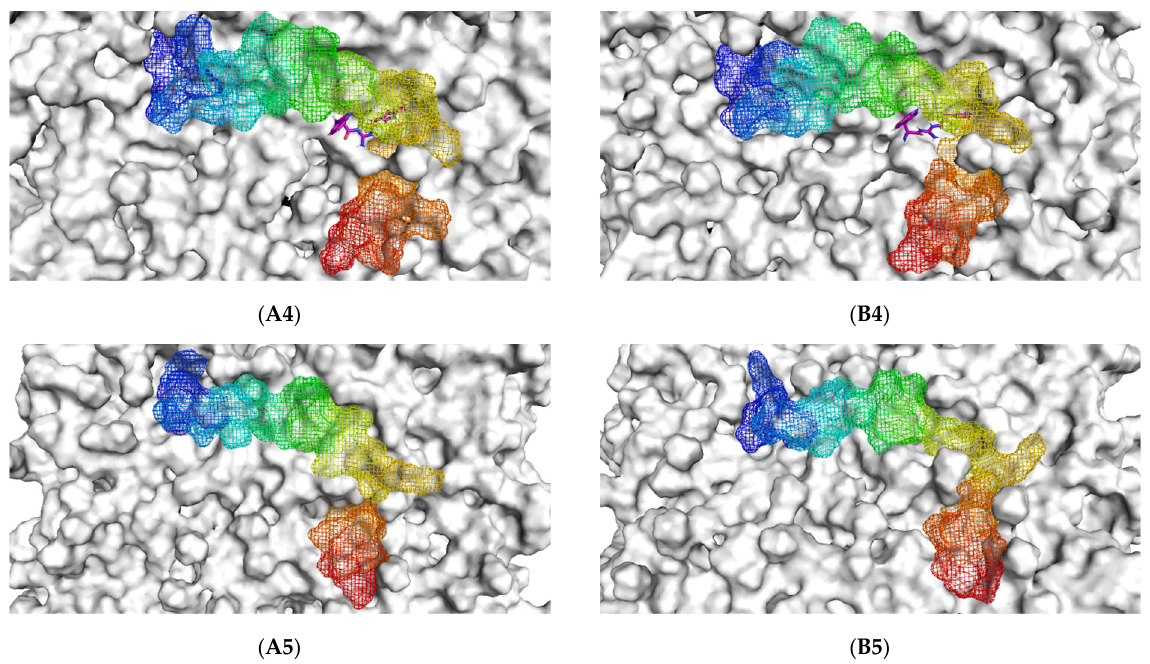
Figure 1. The initial binding mode retrieved from post-equilibration ( A ) and post-200 ns MD simulation binding modes ( B ) of the A β 1–42 monomer (blue to red from N-terminus to C-terminus) and ligands ( 1 ) TGN1, ( 2 ) TGN2, ( 3 ) TGN3, and ( 4 ) TGN4, as well as ( 5 ) no ligand (only A β 1–42 monomer) on the upper-layer surface of the POPC membrane (white).